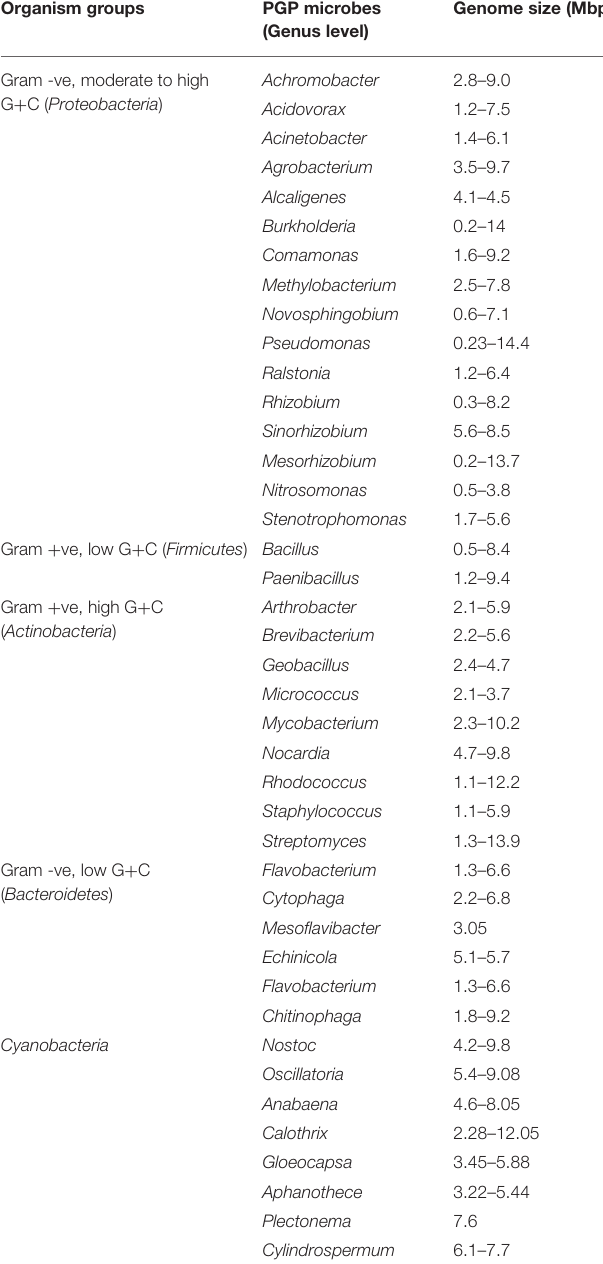
TABLE 2 | List of PGP microbes (genus level) with their genomic details. Organism